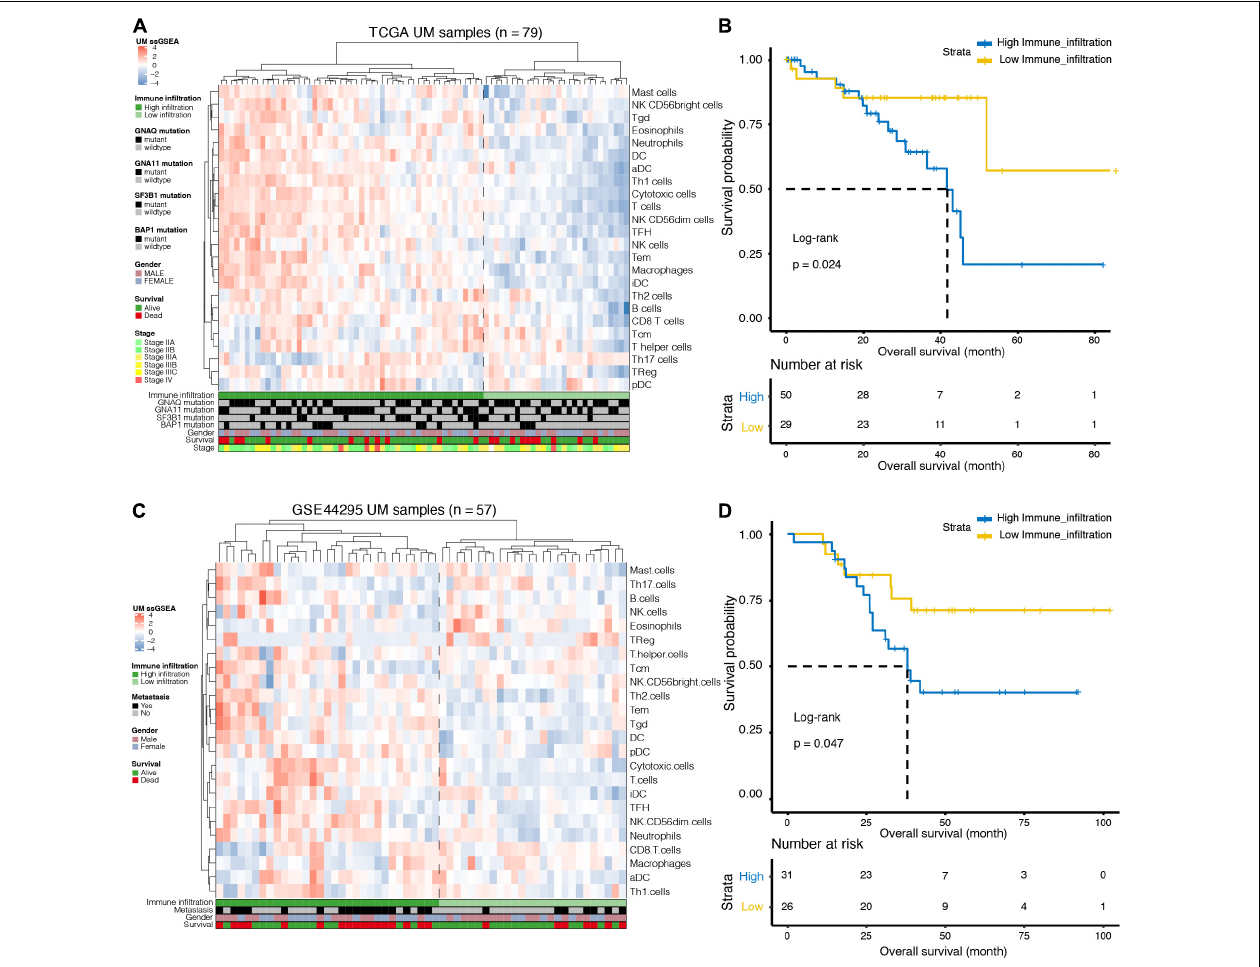
FIGURE 1 | Immune landscape of uveal melanoma (UM). (A) Unsupervised clustering was applied to 79 UM patients from the The Cancer Genome Atlas (TCGA) database using the single-sample gene-set enrichment analysis (ssGSEA) scores of 24 immune cell types. Mutation status of G protein subunit alpha q (GNAQ), G protein subunit alpha 11 (GNA11), splicing factor 3b subunit 1 (SF3B1), and BRCA1-associated protein 1 (BAP1), sex, survival, and stage are annotated in the lower panel. (B) Kaplan–Meier curves for the overall survival (OS) of UM patients in the TCGA dataset grouped by high and low infiltration levels. (C) Unsupervised clustering was applied to 57 UM patients from the GSE44295 dataset using the ssGSEA scores of 24 immune cell types. Metastatic status, sex, and survival are annotated in the lower panel. (D) Kaplan–Meier curves for the OS of UM patients in the GSE44295 dataset grouped by high and low infiltration levels.